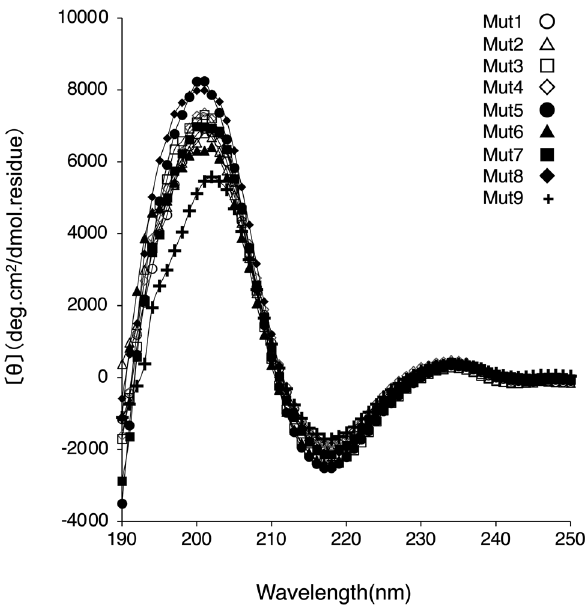
Figure 4. CD spectra of intermolecular SS mutants. The intermolecular SS mutants were dialyzed against 50 mM